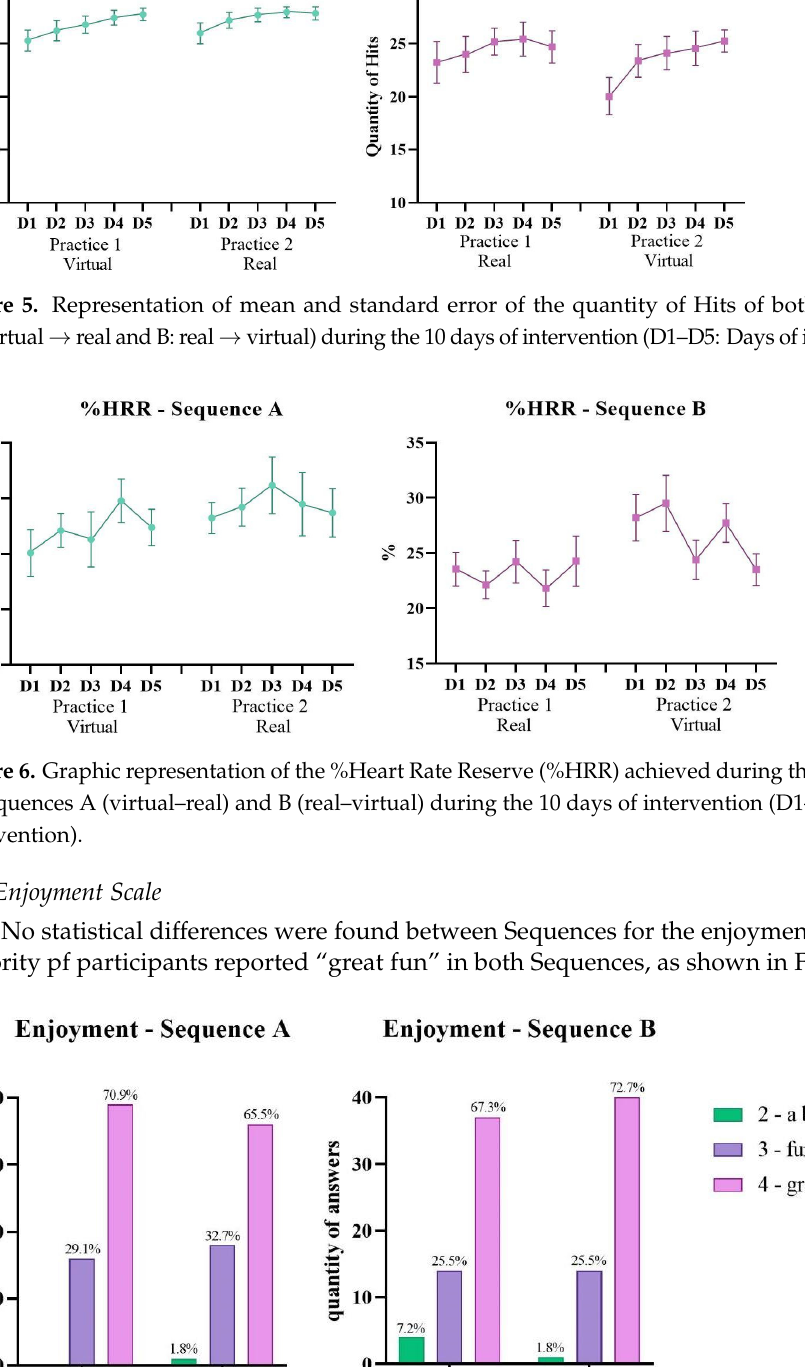
Figure 5. Representation of mean and standard error of the quantity of Hits of both Sequences (A: virtual → real and B: real → virtual) during the 10 days of intervention (D1–D5: Days of intervention).